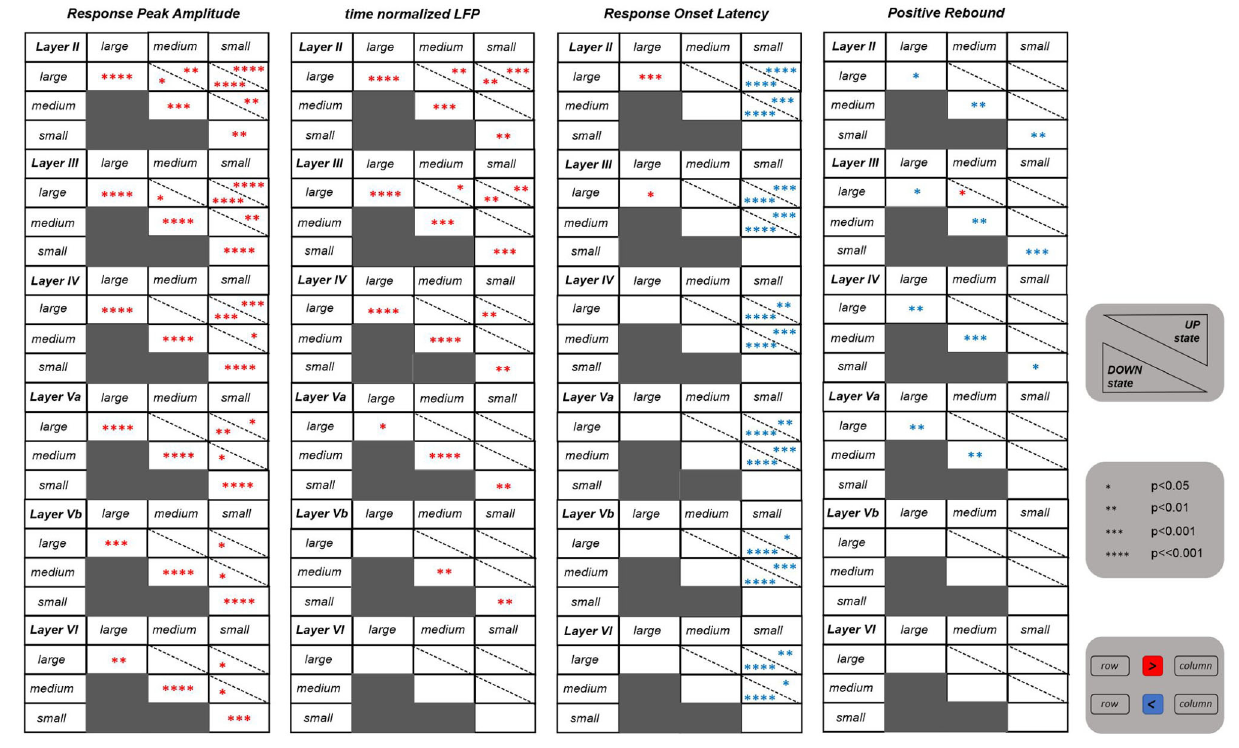
0.05, p 0.01, p 0.001, p ≪ 0.001). The asterisks reported in ≤ ≤ ≤